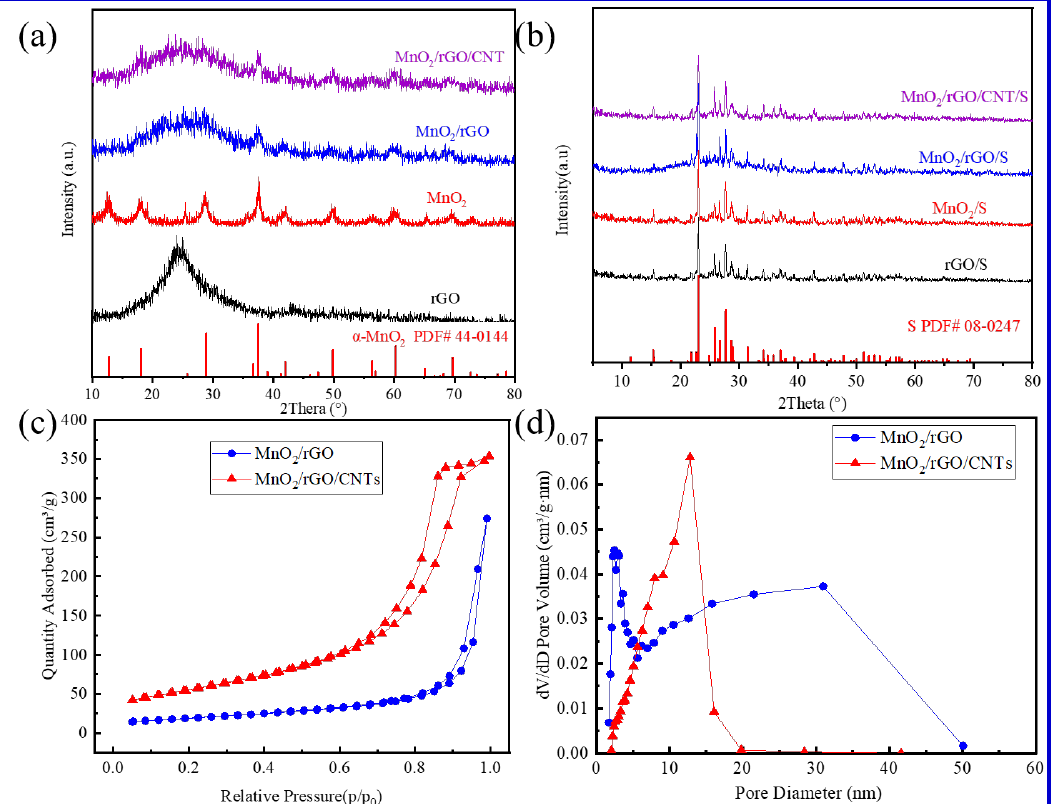
Figure 3. XRD patterns of rGO, MnO 2 , MnO 2 /rGO, and MnO 2 /rGO/CNTs ( a ); XRD patterns of rGO/S, MnO 2 /S, MnO 2 /rGO/S, and MnO 2 /rGO/CNTs/S ( b ); Nitrogen adsorption–desorption isotherms ( c ) and pore size distribution curves ( d ) for MnO 2 /rGO and MnO 2 /rGO/CNTs.